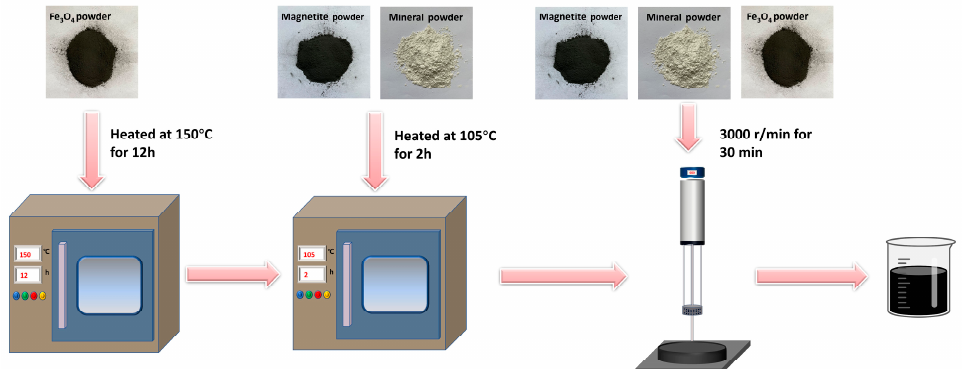
Figure 6. Flowchart of asphalt mastic